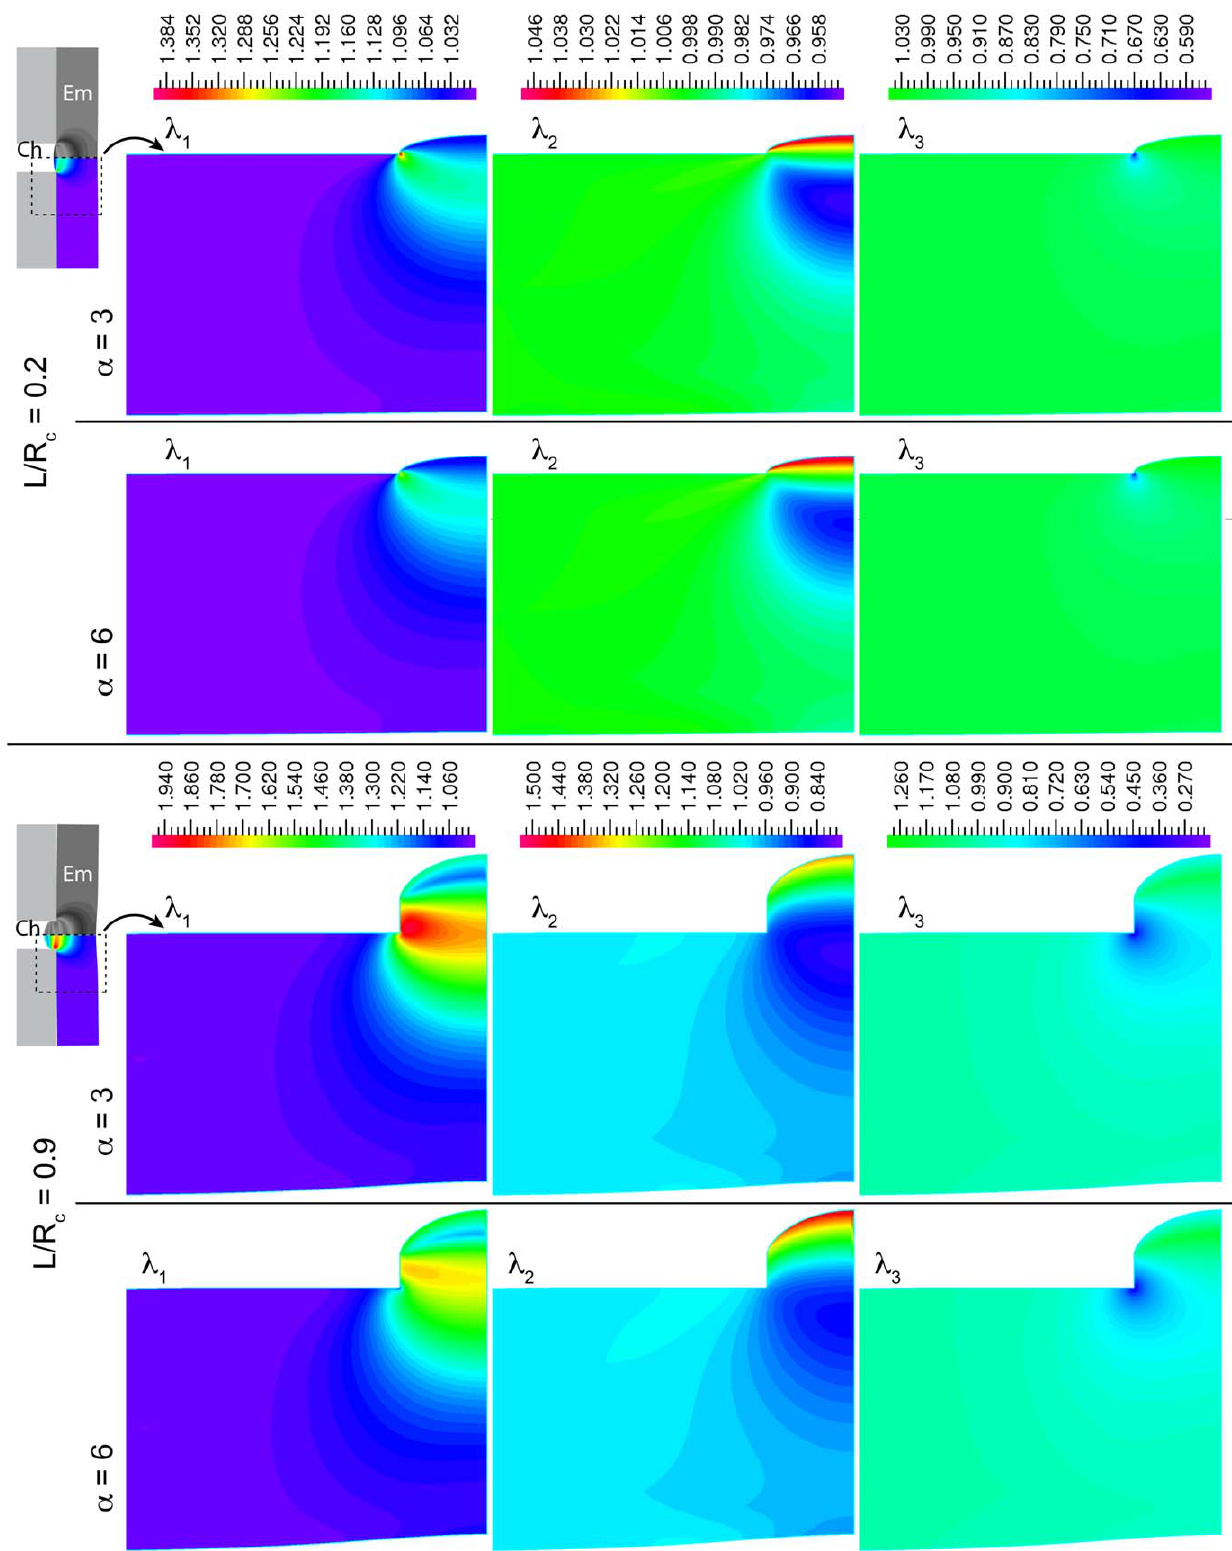
Figure 4. Micro-aspiration produces complex patterns of stretch and compression. Maps of the three principal stretch ratios, l i , for different values of a and different aspirated lengths ‘L’ (relative to channel radius, ‘R c ’), and no friction between the tissue and the channel. Only half of the channel is shown because the model was axisymmetric. The plots were cropped as indicated by dotted lines in the insets (‘Ch’: channel; ‘Em’: embryo). Deformations outsideoftheenlargedregionwere lowandnearly uniform.Notethatthecolorscales differfordifferentprincipalstretches,andfordifferentaspiratedlengths.